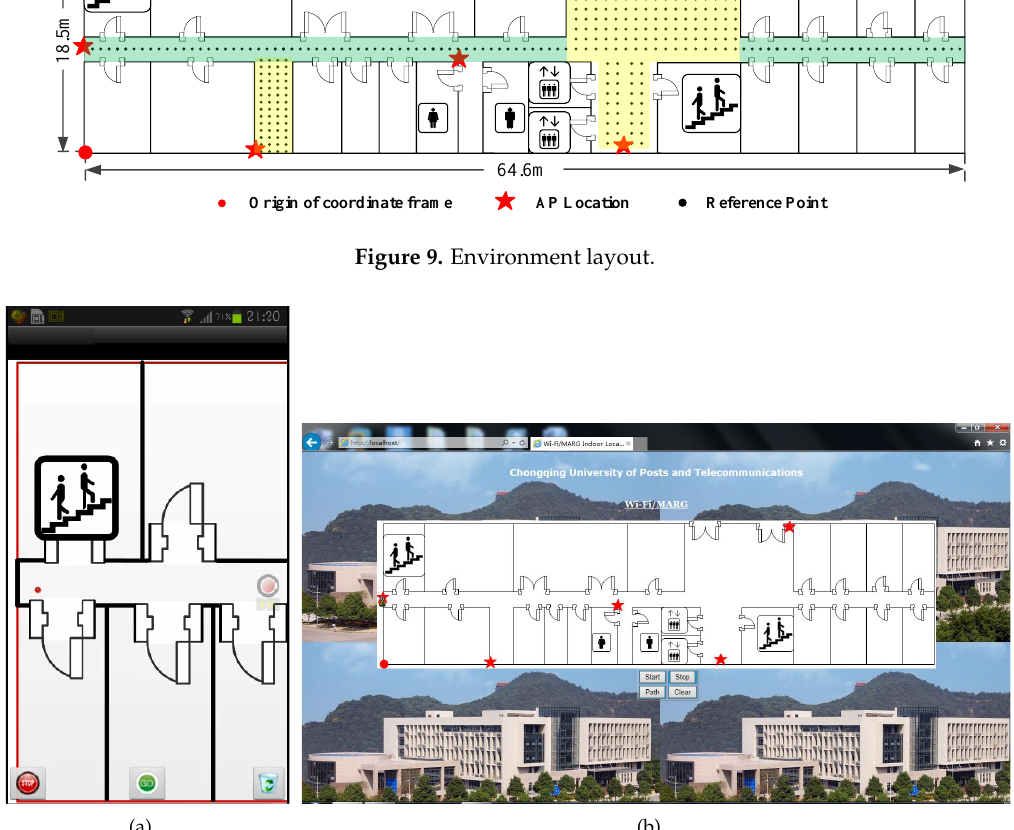
Figure 10. Interface of our developed software. ( a ) Mobile client; ( b ) Remote